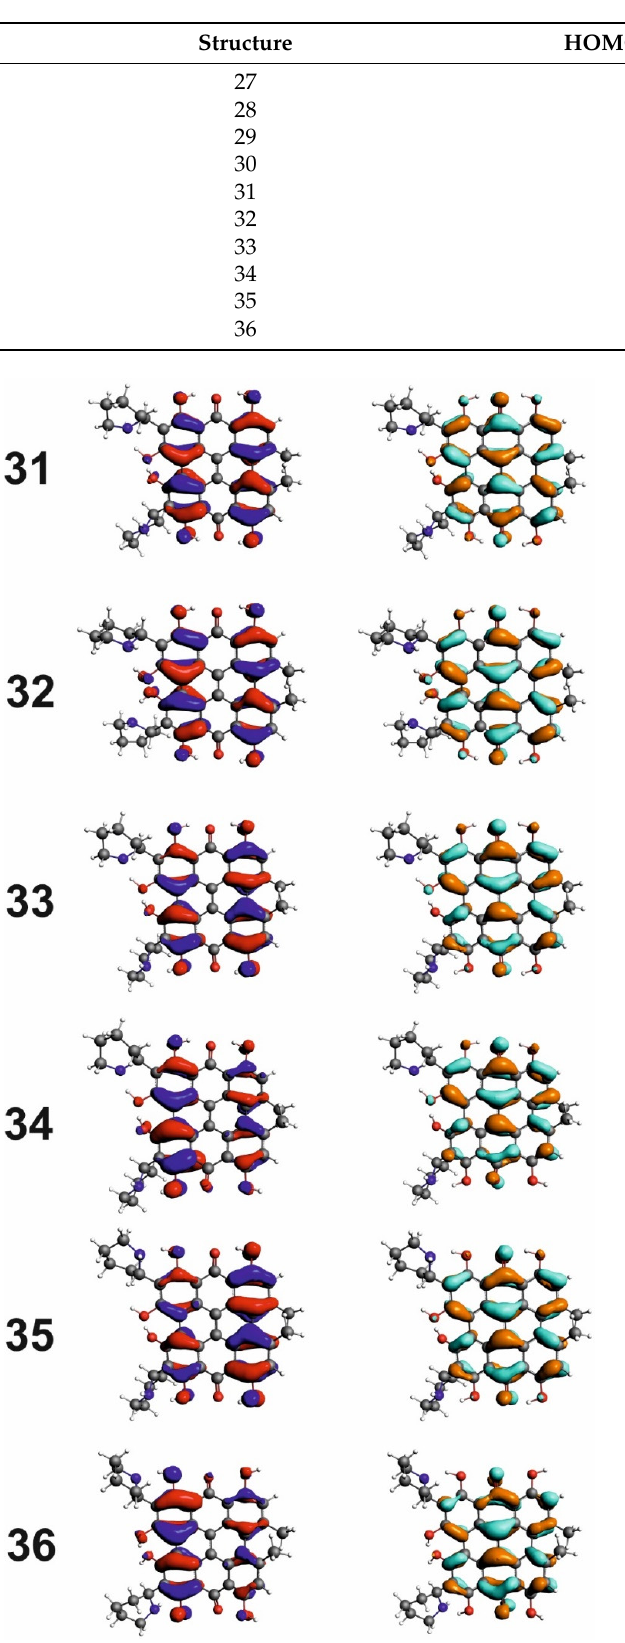
Figure 10. HOMO and LUMO orbitals for the fagopyrin F conformers 31, 32, 33, 34, 35, and 36. Table 3. HOMO–LUMO gap energy for calculated fagopyrin structures.